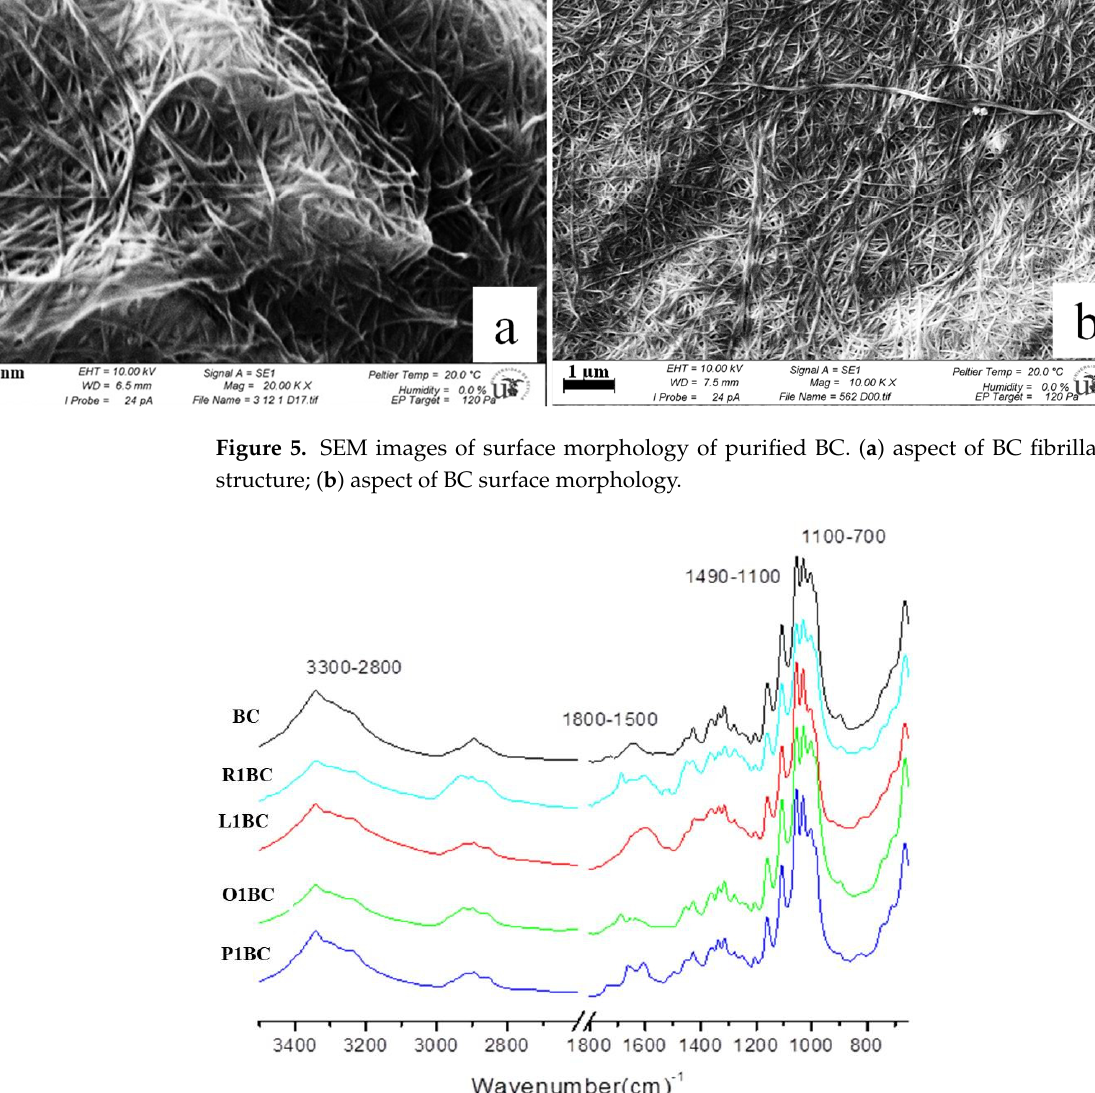
Figure 7. FT-IR spectra of lovage extract (L1) and bacterial cellulose incorporated with lovage extract (L1BC).